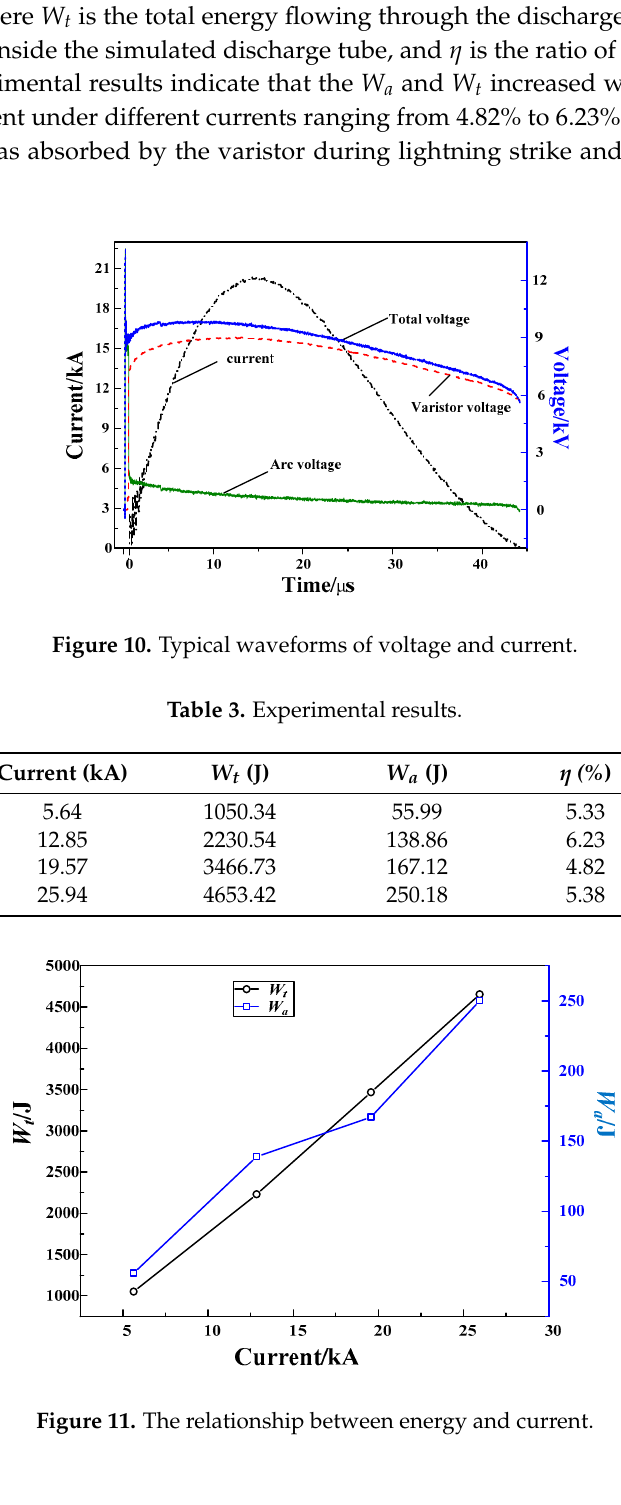
Figure 11. The relationship between energy and current.